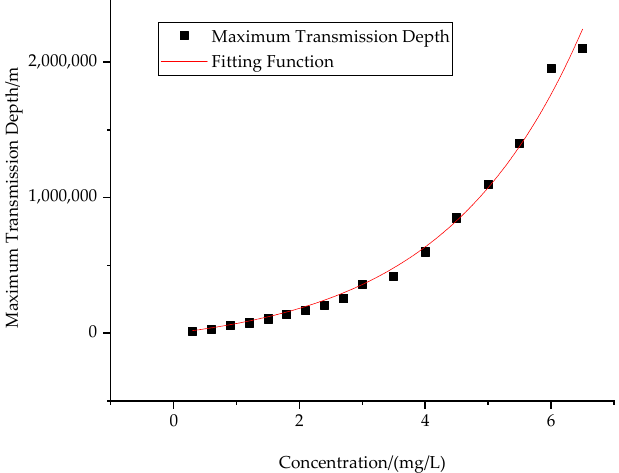
Figure 6. Minimum initial photon number at different concentrations.